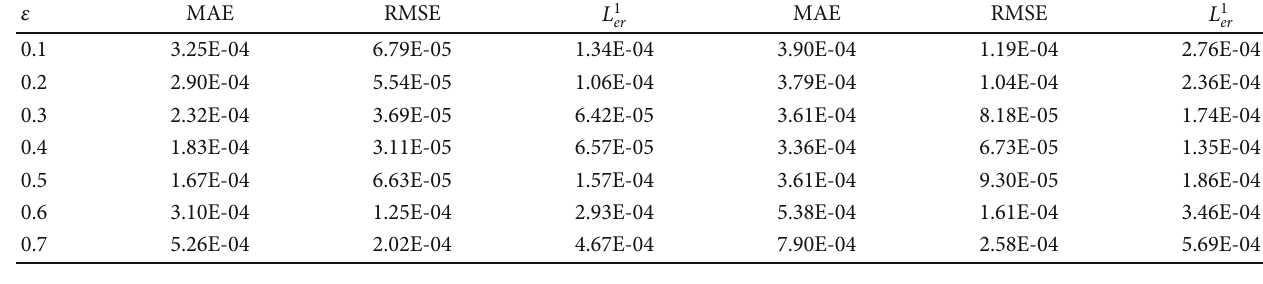
Table 5: Results for di ff erent values of ε in Example 1 with N and Neumann conditions.